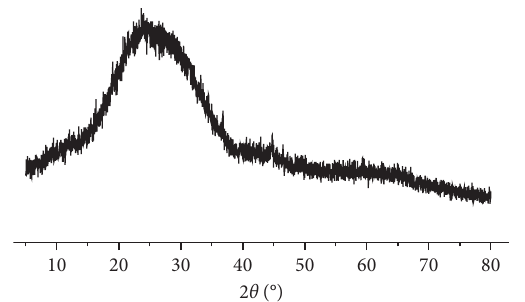
Figure 2: XRD spectrum of the nickel slag